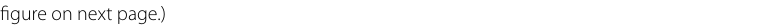
figure on next Fig. 1 Prevalence and age distribution of myositis patients in Germany. A Shown are the standardized absolute values of myositis patients in the observation period from 2005 to 2019 in Germany. B–E Age distribution of the total myositis cohort. ( B ) and the myositis subgroups ( C–E ) and the chronological trend during the observation period from 2005 to 2019per 100,000 insured persons. DM dermatomyositis, IM interstitial myositis, PM polymyositis, OM other